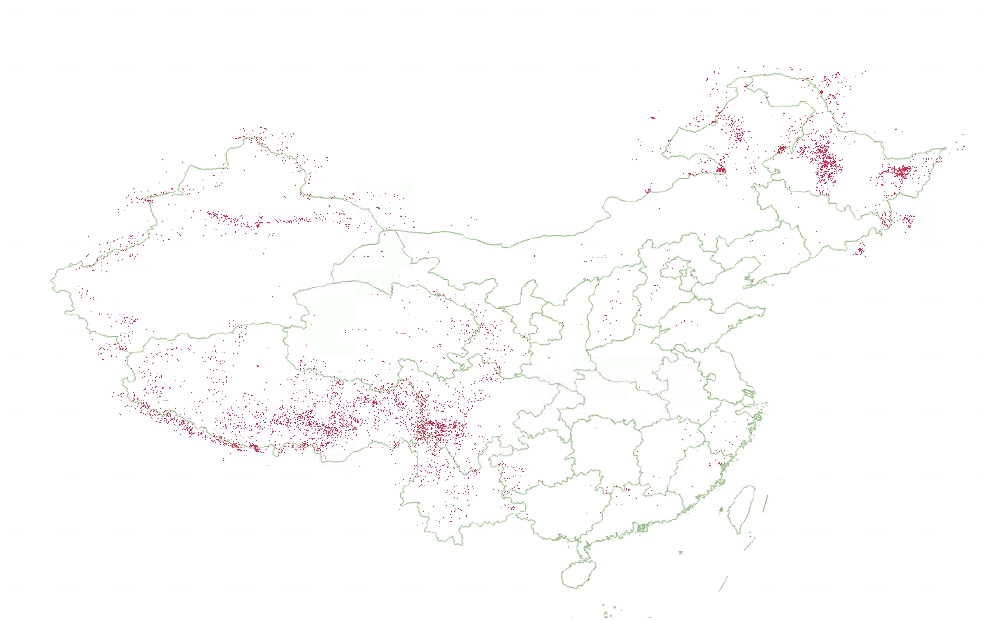
Figure 9. Mosaic image of forest cover products